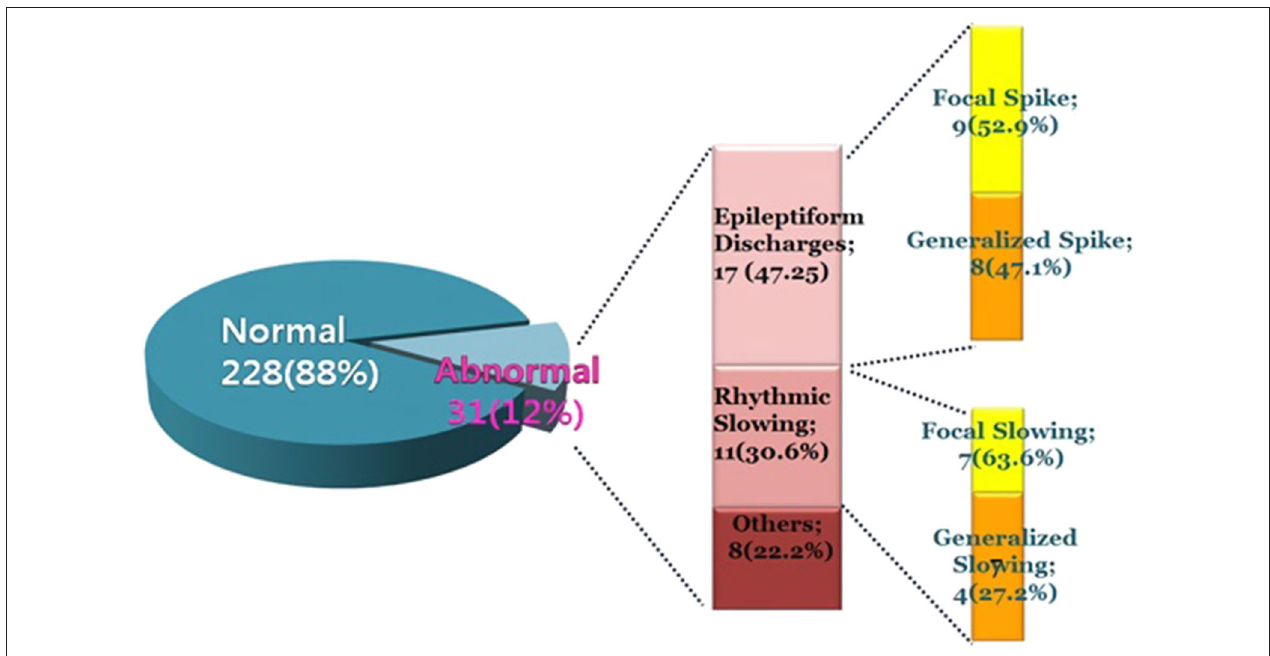
FIGURE 1 | Classification of abnormal electroencephalogram (EEG) findings.